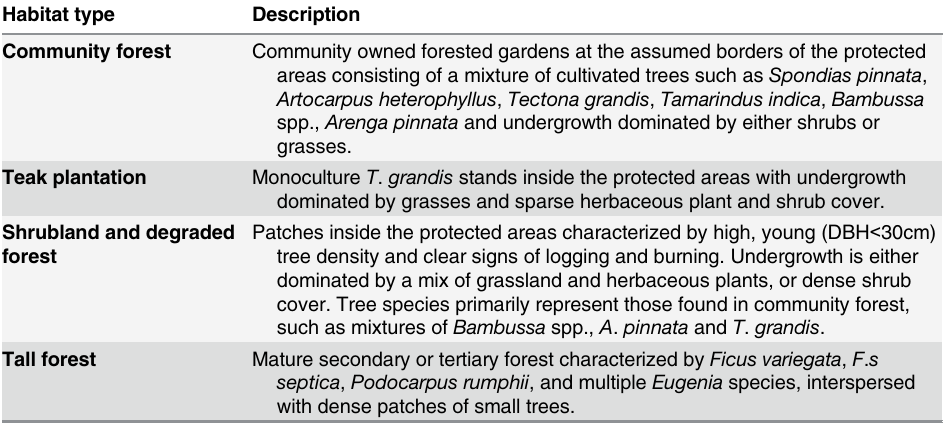
Table 1. Distinct habitat types found at the study site. Adapted from Nijman [17]. Habitat